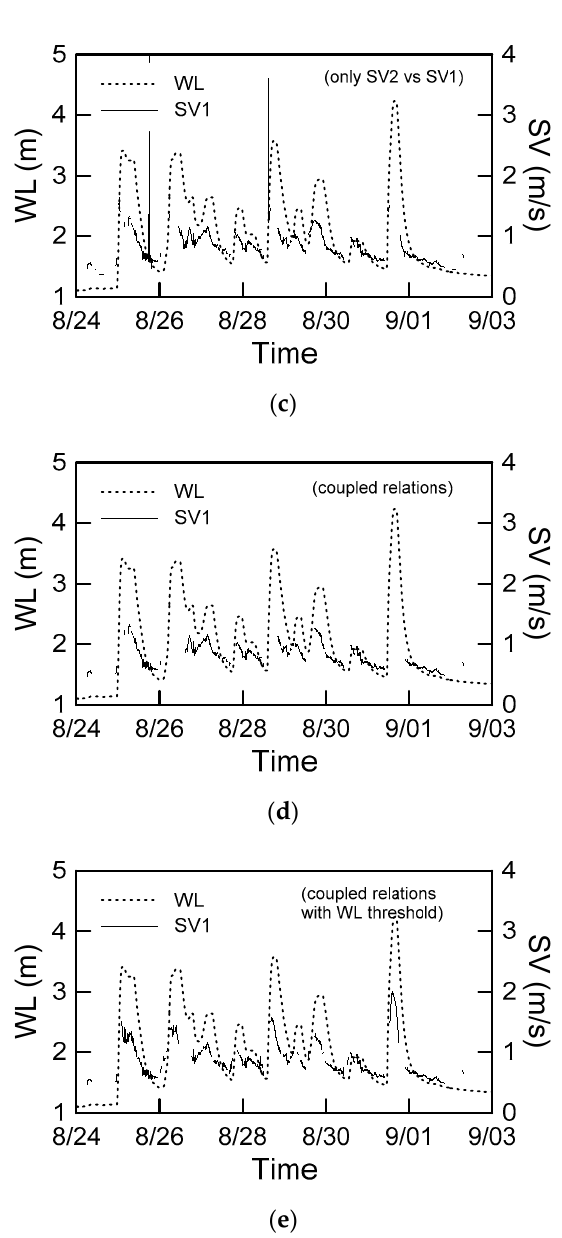
Figure 10. Filtered time series of SV at Wulilin Bridge: ( a ) raw data; ( b ) filtered only by SV vs. WL relation; ( c ) filtered only by the relation between the two SVs; ( d ) filtered by coupled relations; ( e ) filtered by coupled relations with approximate WL threshold.